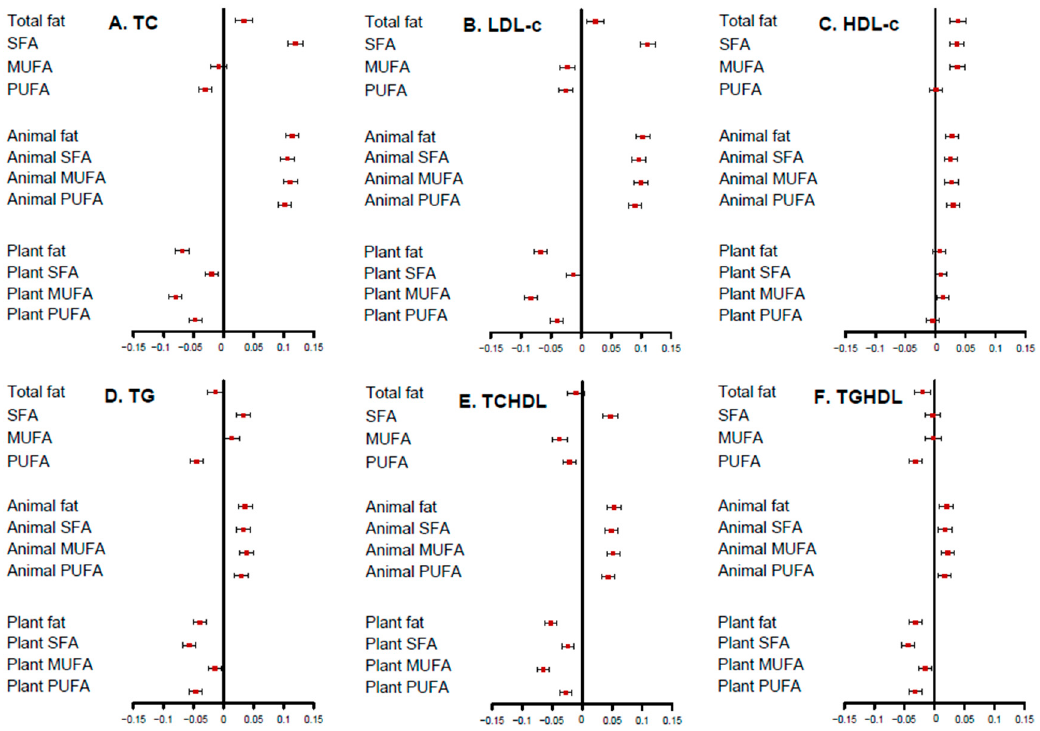
Figure 1. Standardized regression coefficients for the relationships of various fats with lipid biomarkers. Adjusted for total energy, dietary fiber, dietary cholesterol, vegetables, fruits, age, sex, north/south region, urban/rural location, education (categorical), smoking (categorical by status and cigarettes), drinking status (categorical by grams), BMI (continuous), physical activity (continuous), sleep time (continuous), diagnosed hypertension (yes/no), and family history (yes/no). Abbreviation: SFA, saturated fatty acids; MUFA, monounsaturated fatty acids; PUFA, polyunsaturated fatty acids; TC, total cholesterol; LDL-c, low-density lipoprotein; HDL-c, high-density lipoprotein; TG, triglyceride; TCHDL, TC-to HDL-c ratio; TGHDL, TG to HDL-c ratio; BMI, body mass index.